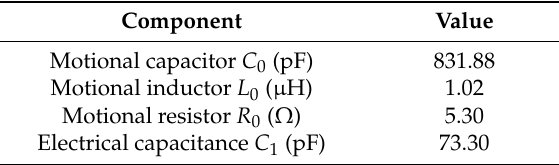
Figure 1. Capacitive micromachined ultrasonic transducer (CMUT) electrical equivalent model. ( a ) A single CMUT element consists of 30 × 30 cells; and ( b ) Butterworth-van-Dyke (BvD) equivalent circuit model of the CMUT element. Table 1. Parameters of the capacitive micromachined ultrasonic transducer (CMUT) element electrical equivalent model.